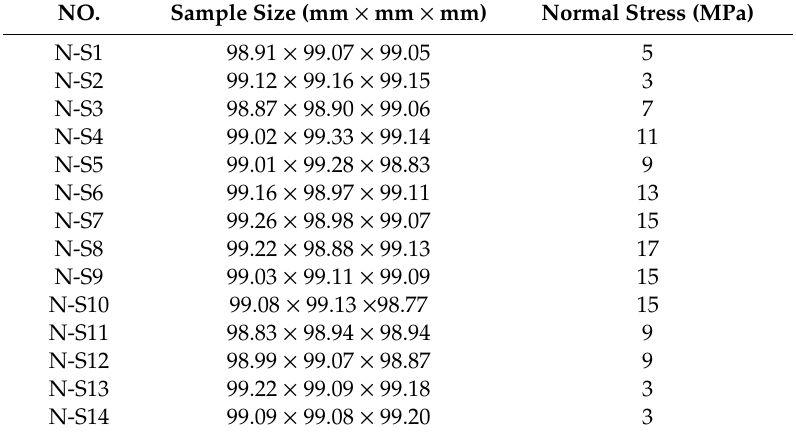
Table 1. Sizes of the cubic granite samples and the applied normal stresses for direct shear